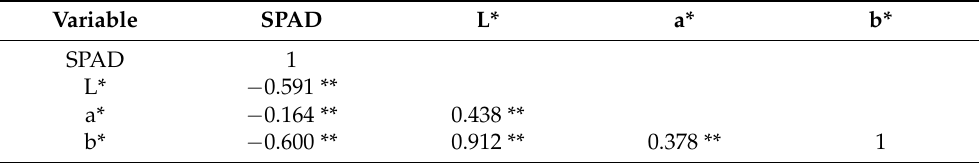
Table 2. Relationships among SPAD, L*, a*, and b* of wheat leaves. Variable SPAD L*